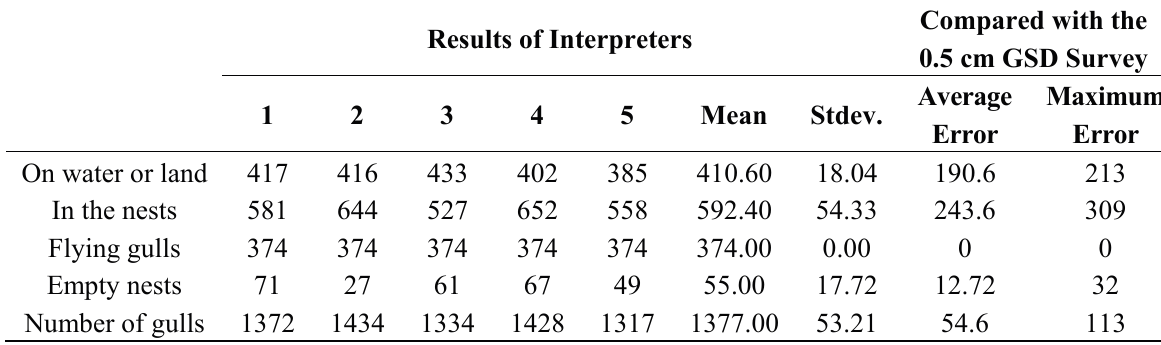
Table 4. Interpreter results from the 7 cm spatial resolution ortho